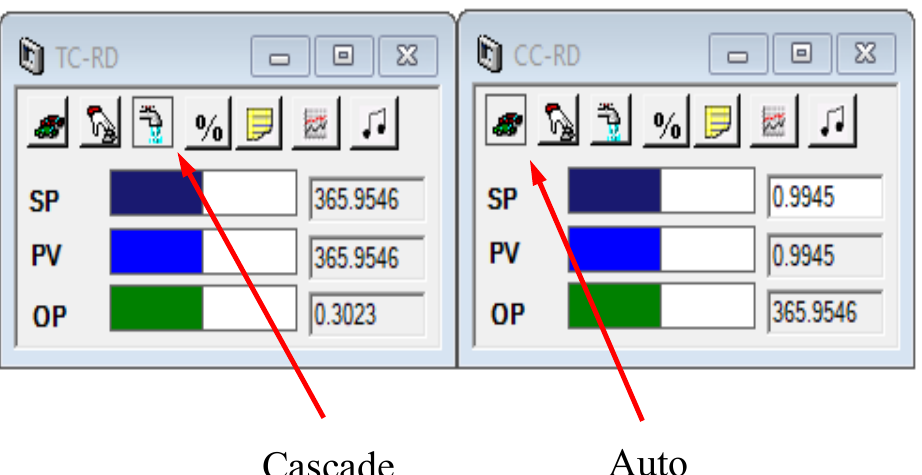
Figure 12. Cascade control scheme faceplates of the process.